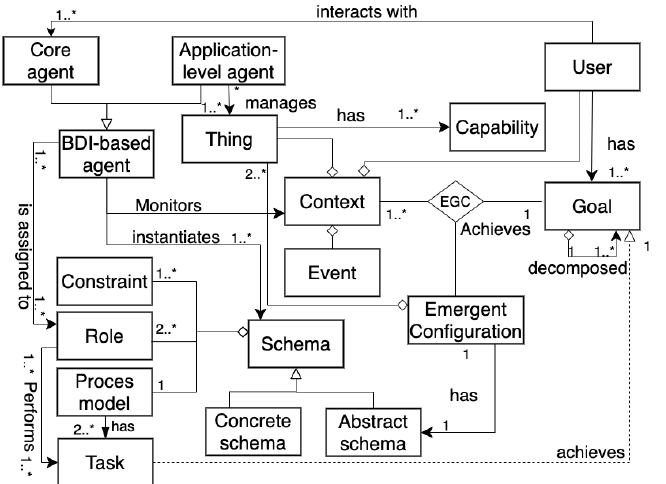
Figure 1. Conceptual model of the approach (described in